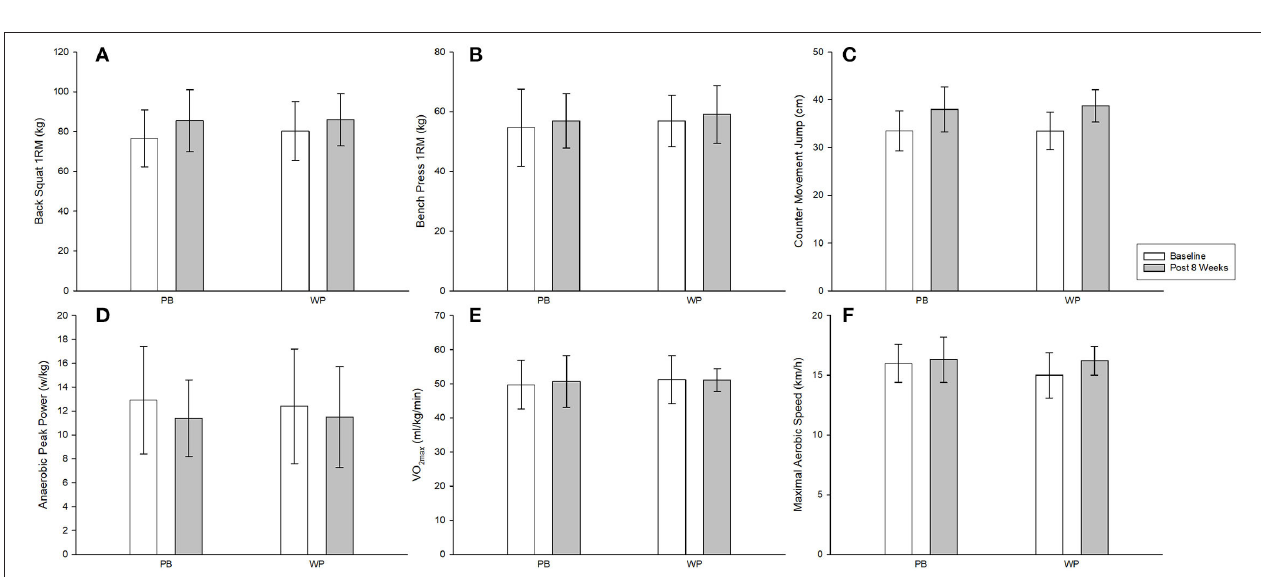
FIGURE 2 | Changes ( 1 baseline-week 8) in lean body mass (A) , fat mass (B) during the 8-week supplementation protocol. Data are shown as box and whisker plots where whiskers are the maximum and minimum and the box represents the interquartile range, the line the group median. Dots represent outliers. *Represents an observed time effect. PB, plant-based protein; WP, whey protein.